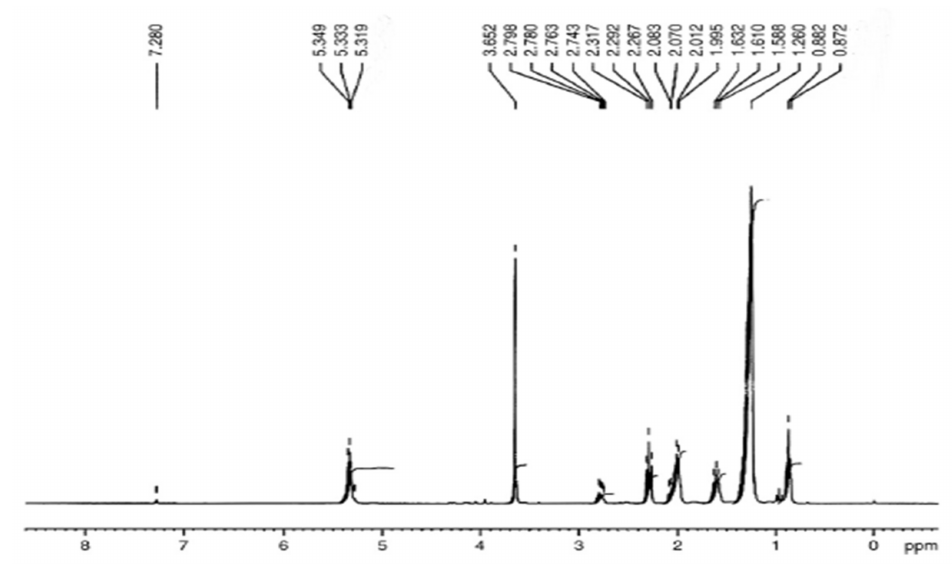
Figure 22. 1 H NMR spectrum of Prunus aitchisonii oil biodiesel treated with KPC.